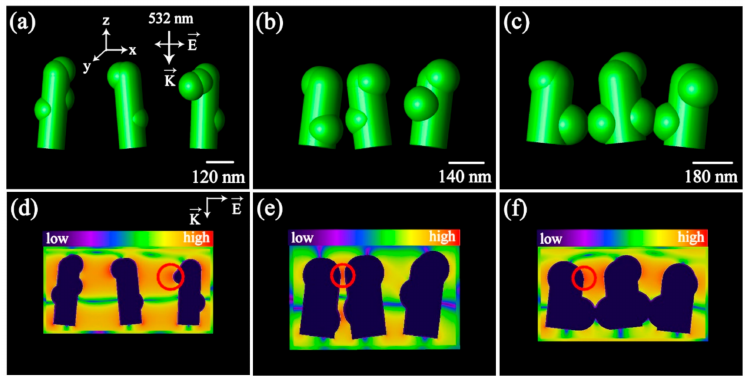
Figure 3. ( a – c ) The 3D-FDTD models of Ag/FCW-5, Ag/FCW-10 and Ag/FCW-15, respectively; and ( d – f ) x-z views of the electric field distribution around corresponding substrates in ( a – c